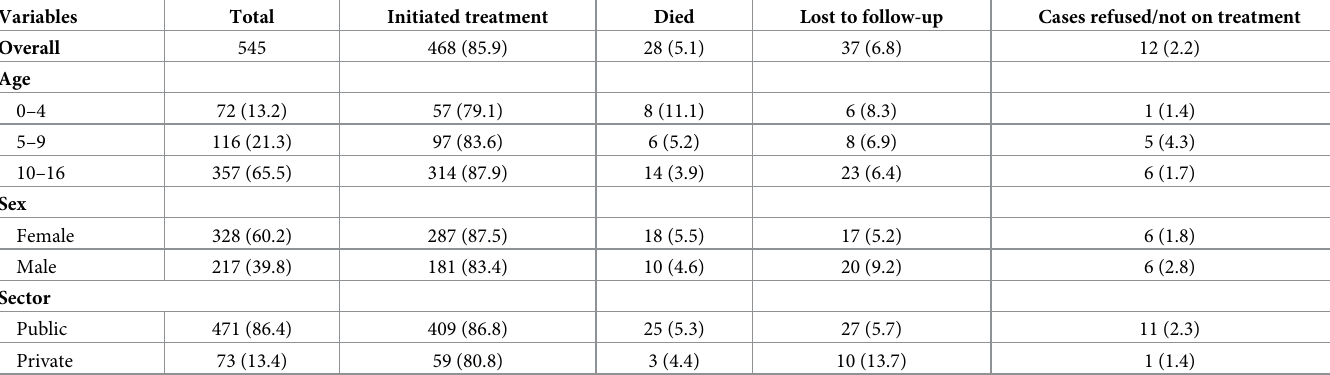
Table 5. Treatment initiation status of bacteriologically confirmed rifampicin resistant TB cases.